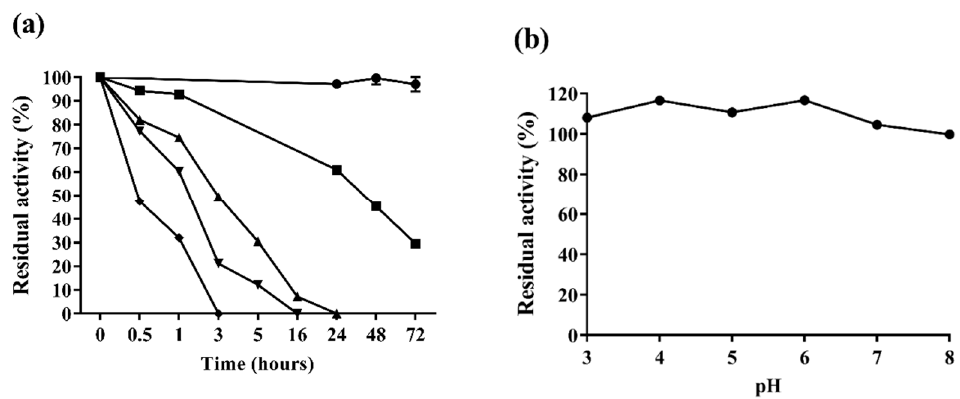
Figure 3. Plots of Af-EGL7 residual activity against incubation time at different temperatures and pH. ( a ) Af-EGL7 stability at ● 55 °C, ■ 60 °C, ▲ 70 °C, ▼ 80 °C, and ♦ 90 °C. ( b ) Af-EGL7 stability in the pH range 3.0–8.0. Error bars represent standard deviation ( n = 3).